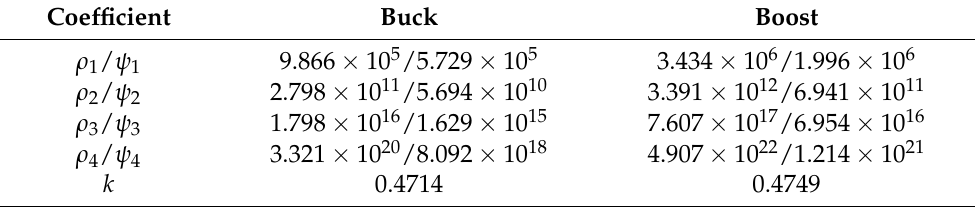
Table 3. Coefficients for approximation of the fractional-order PID controller (17).